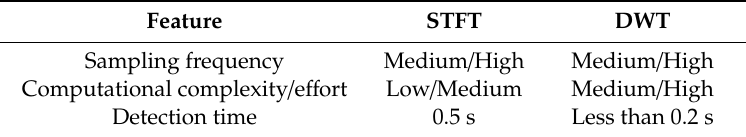
Comparison between Short-Time Fourier Transform (STFT) and Discrete Wavelet Transform (DWT).